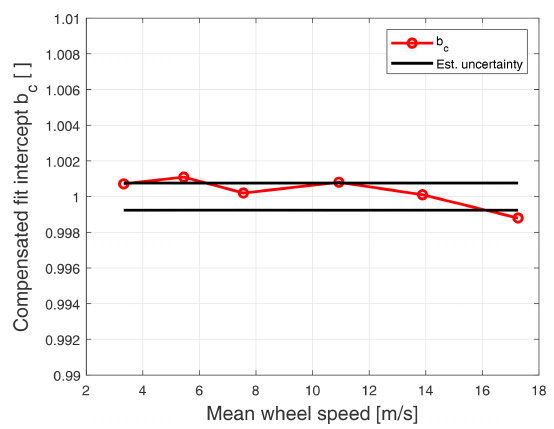
Figure 16. Compensated fit intercepts together with the estimated standard